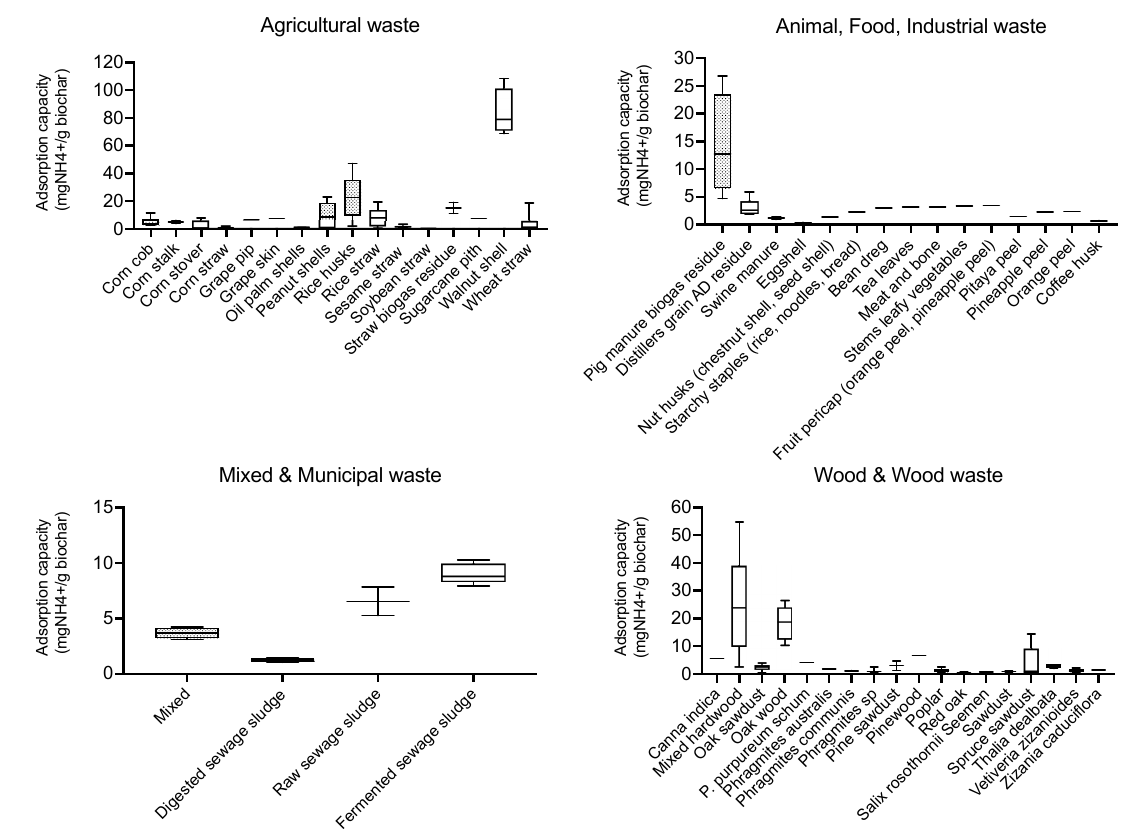
Figure 1. Adsorption capacities of different materials.